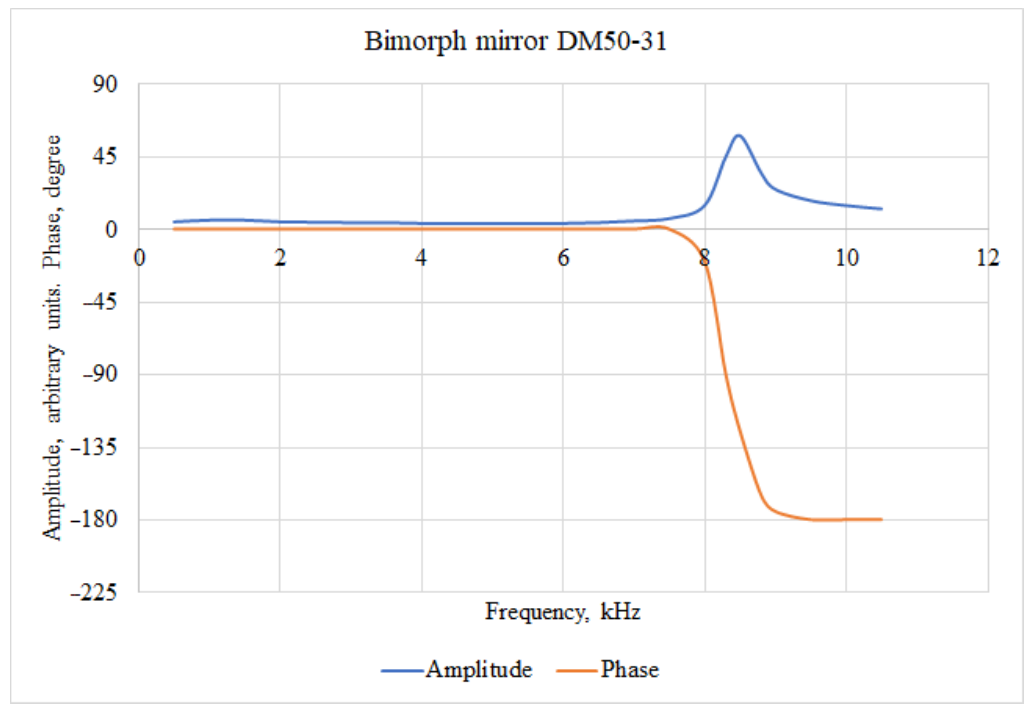
Figure 1. Bode diagram for bimorph deformable mirror.